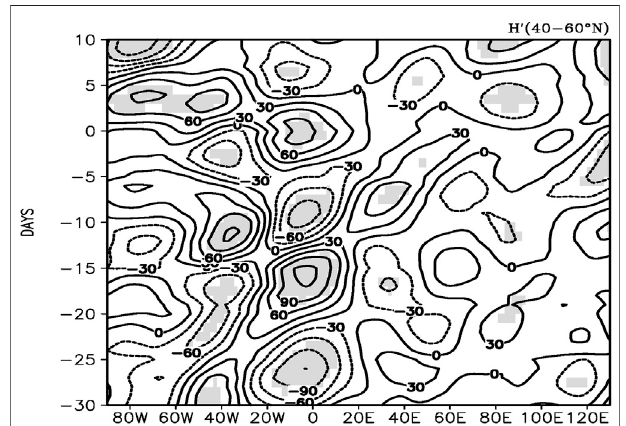
FIGURE 7 | Composite temporal-longitude pro fi le of quasi-biweekly geopotential height averaged from 40 ° N to 60 ° N at 500 hPa from day -30 to day 0 (unit: gpm), the shadowed area indicates that it has passed the 95% con fi dence test.